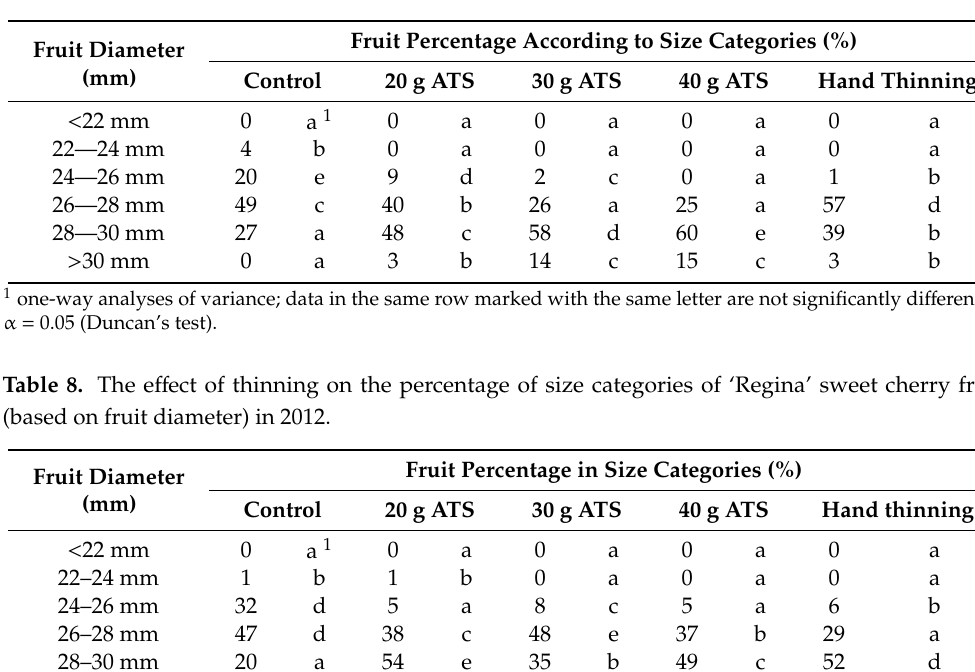
Table 7. The e ff ect of thinning on the percentage of size categories of ‘Regina’ sweet cherry fruit (based on fruit diameter) in 2009.